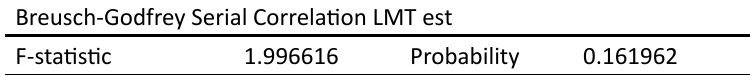
Table 5: LM Test